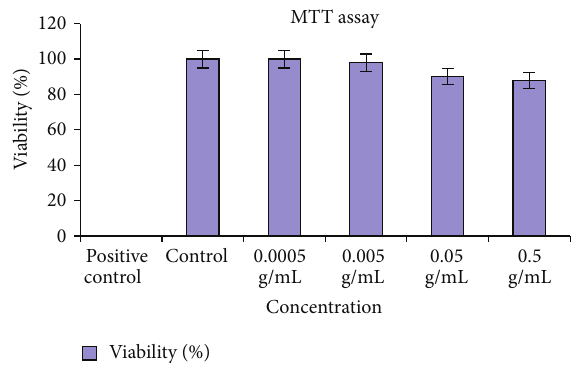
Figure 3: Cell viability by MTT assay. All values are expressed as mean ± Std. deviation ( 𝑛 = 6